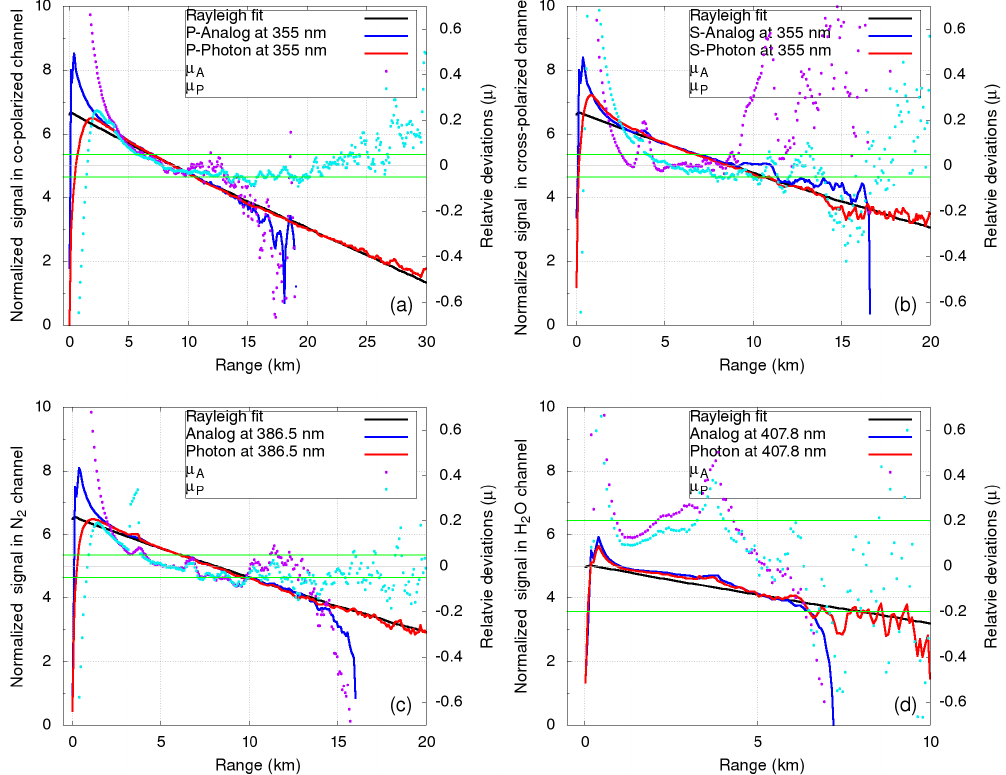
Figure 8. Rayleigh fit (black) to the normalized range square-corrected signals from the analog (blue) and photon counting (red) detection chains for the UV signals at 24:00 CET on 14 January 2019. Pink and light blue dots indicate deviations from the attenuated molecular backscatter coefficients calculated from the radiosonde data at Udine. Horizontal green lines indicate the individual deviations. ( a ) LiDAR signal in the P (cid:107) channel at 355nm, ( b ) LiDAR signal in the P ⊥ channel at 355nm, ( c ) LiDAR signal in the N 2 channel at 387.5nm, ( d ) LiDAR signal in the H 2 O channel at